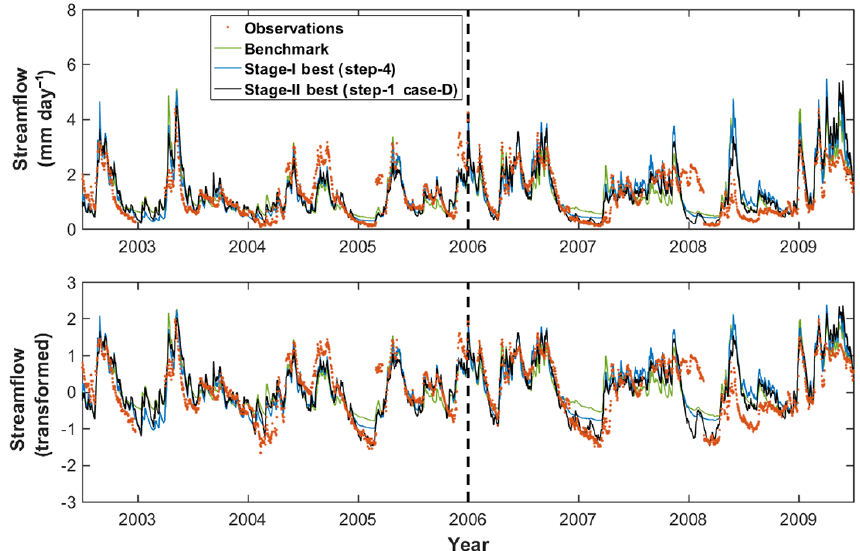
Figure 10. Time-series plots of streamflow for the best simulations in Stage-I and Stage-II, the benchmark simulation, and the observations.